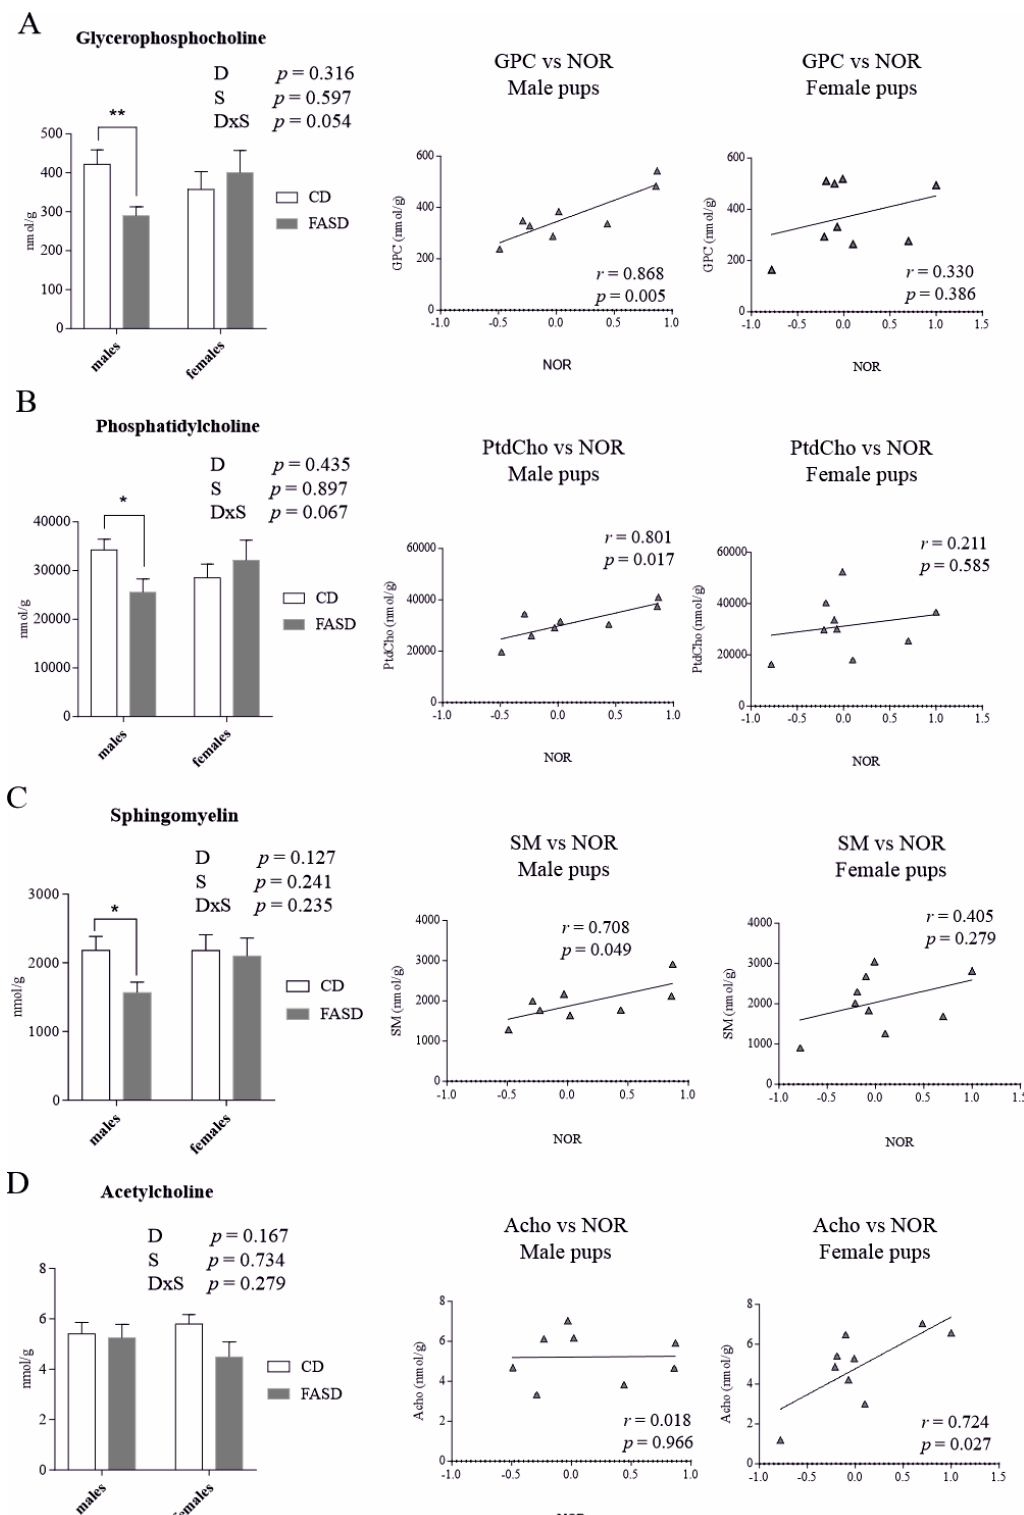
Figure 5. Concentrations of choline-derived metabolites measured by LC-MS in offspring cerebral cortex. ( A ) FASD male pups showed a reduction in GPC compared to CD male pups; females did not show dietary changes. GPC concentration in male pups positively correlated with the DI in the NOR test; female pups did not show a significant correlation. ( B ) FASD male pups showed a reduction in PtdCho compared to CD males; females did not show dietary changes. PtdCho levels in male pups positively correlated with the DI in the NOR test; female pups did not. ( C ) FASD male pups showed